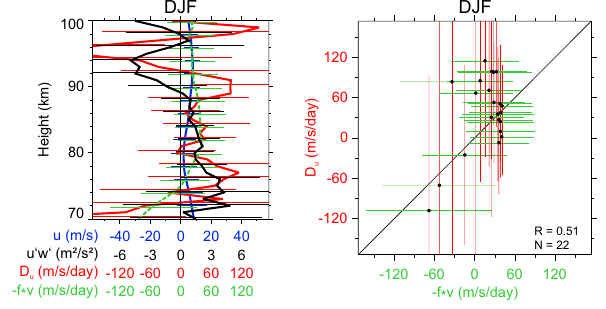
Figure 2. Vertical profiles (left) of 3-month mean zonal wind u (blue), vertical flux of zonal GW momentum u (cid:48) w (cid:48) (black), zonal GW drag D u (red) and negative Coriolis acceleration of the mean meridional wind − f · v (dashed green) from SMF radar measure- ments in summer 2010. Horizontal lines denote the SD of each quantity at each height and are plotted every 2km for simplicity. The scatter plot of − f · v and D u (right) including the SDs for 71 to 92km altitude under specification of the correlation coefficient R and the number of values N . See text for further information.